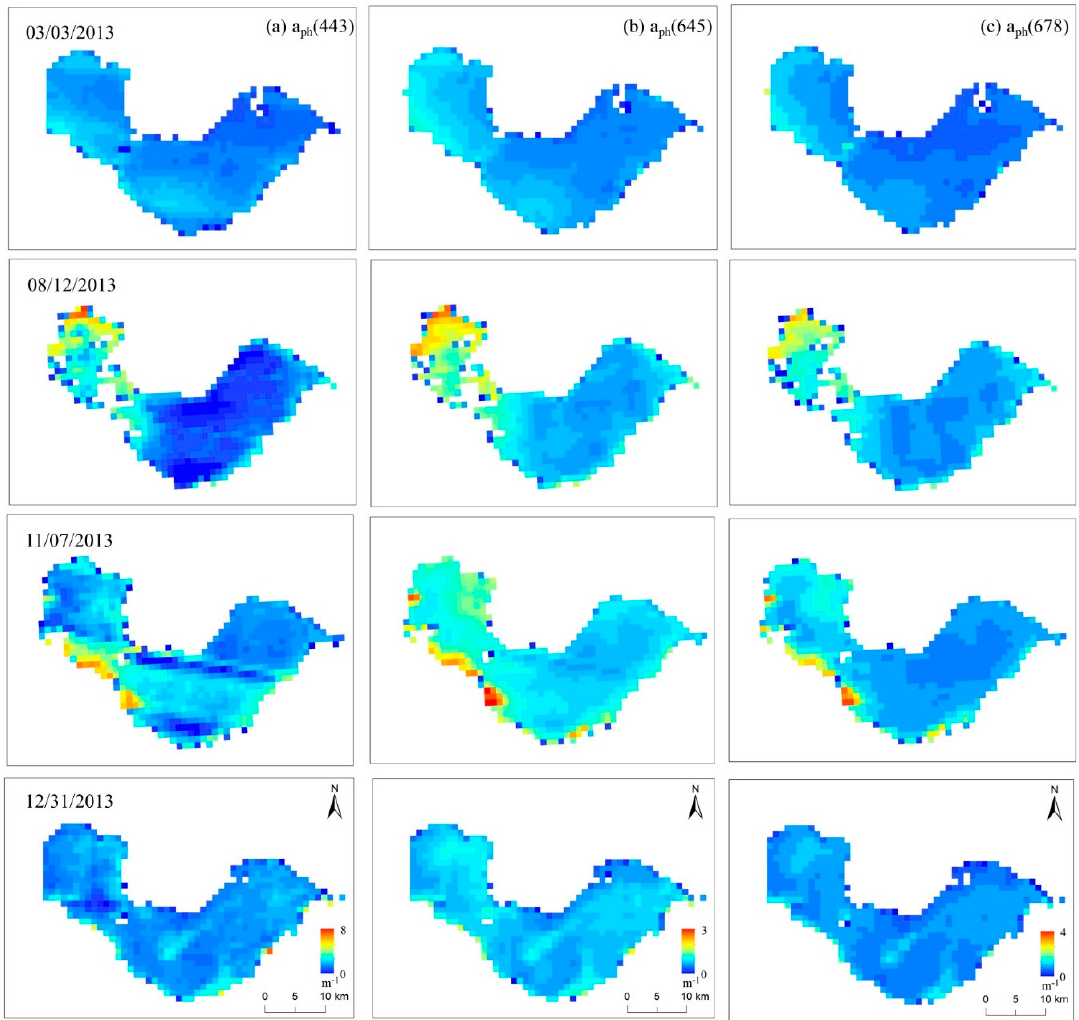
Figure 14. The calculated a ph at ( a ) 443, ( b ) 645, ( c ) 678 nm in four seasons of Lake Chaohu.